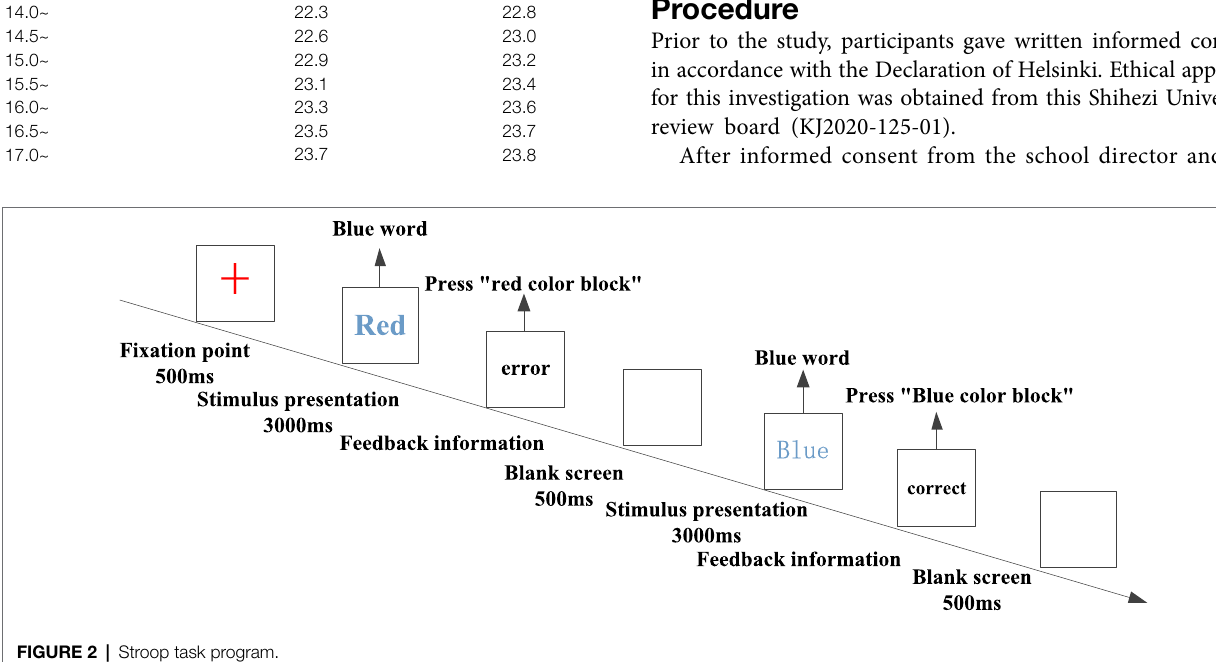
FIGURE 2 | Stroop task program.